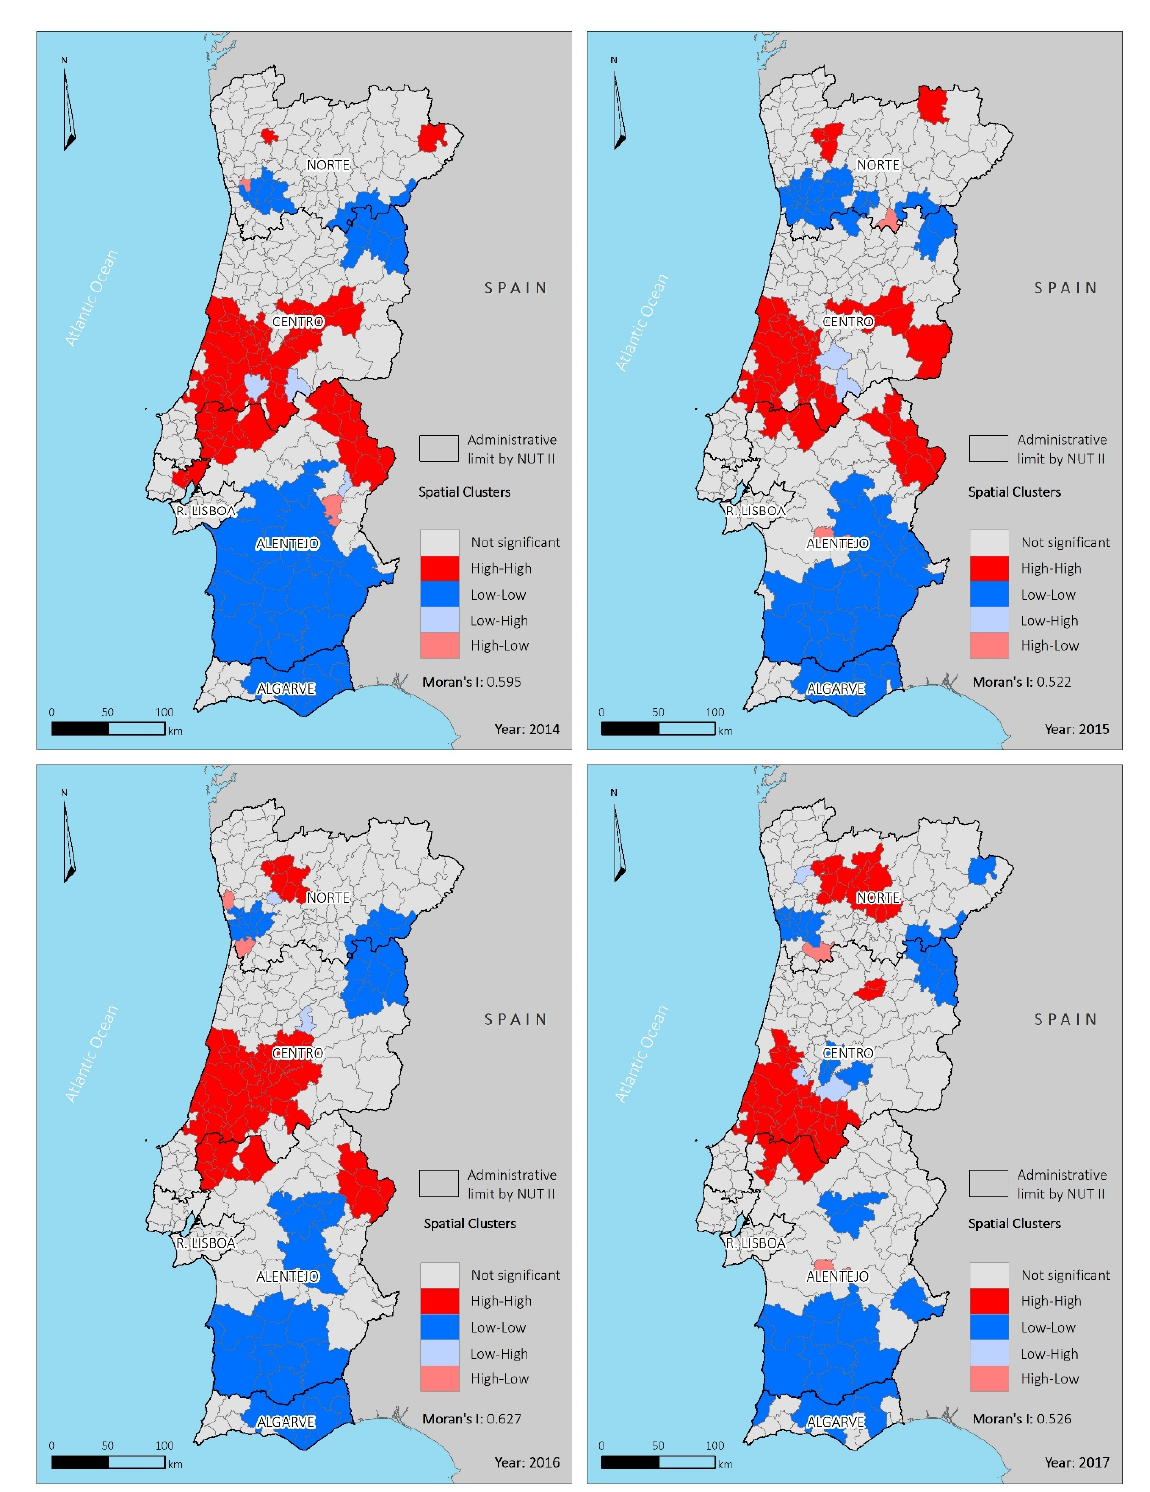
Figure 3. The spatial clusters of ASHR by municipality for the period 2014–2017.